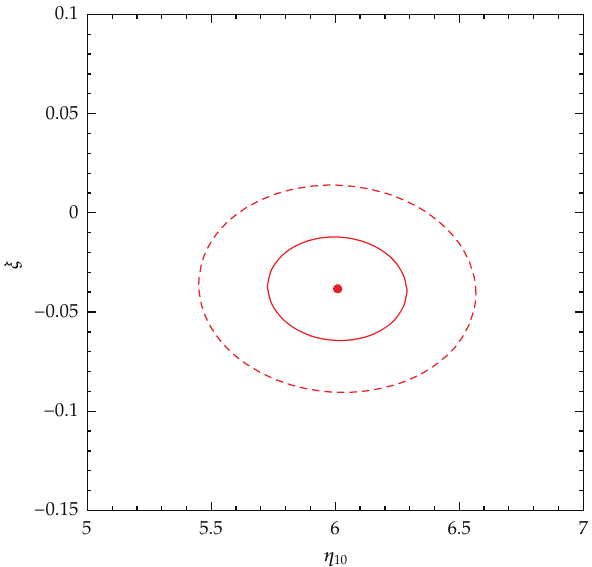
Figure 6: The BBN-inferred 68% (cid:3) solid (cid:4) and 95% (cid:3) dashed (cid:4) contours in the ξ - η 10 plane derived from D and (cid:7) 4 He assuming that Δ N ν